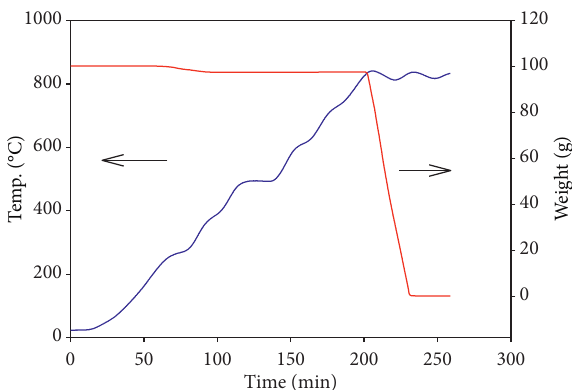
Figure 3: Profiles of sample weight and temperature as a function of time (steel ball